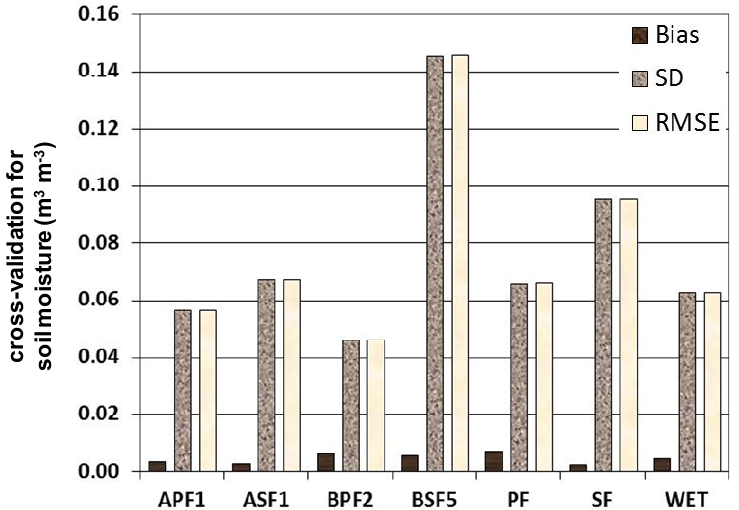
Figure 7. Error statistics of the empirical approach ( Δ -Index cross polarization coefficient): bias and standard deviation (SD), as well as the RMSE . IA: FQ16 (36°) and FQ20 (39°). APF1: permanently flooded peatland A ; ASF1: seasonally flooded peatland A ;